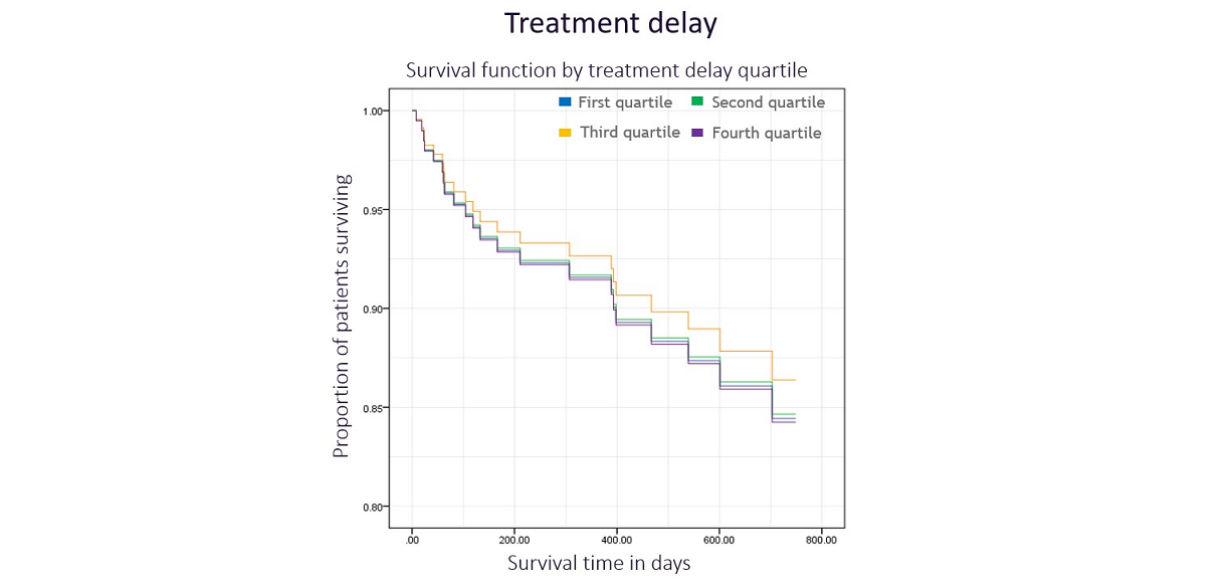
Figure 6. Kaplan-Meier plot illustrating the survival function by treatment delay quartile with